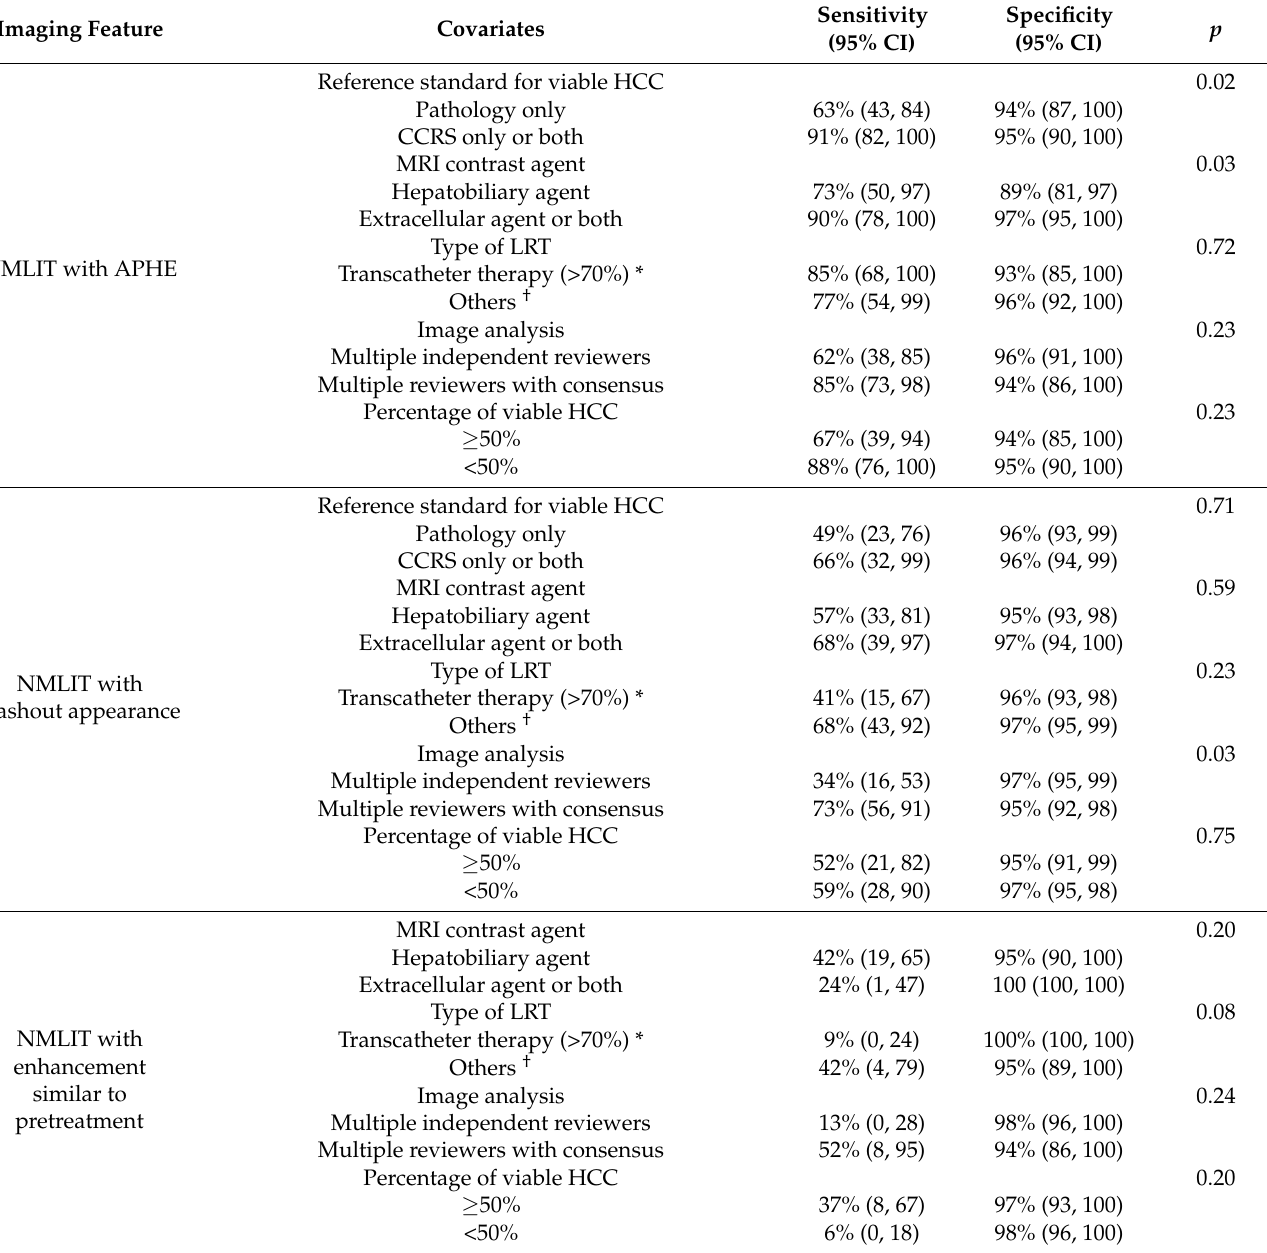
Table 3. Meta-regression analysis of accuracy for imaging features of LR-TR viable